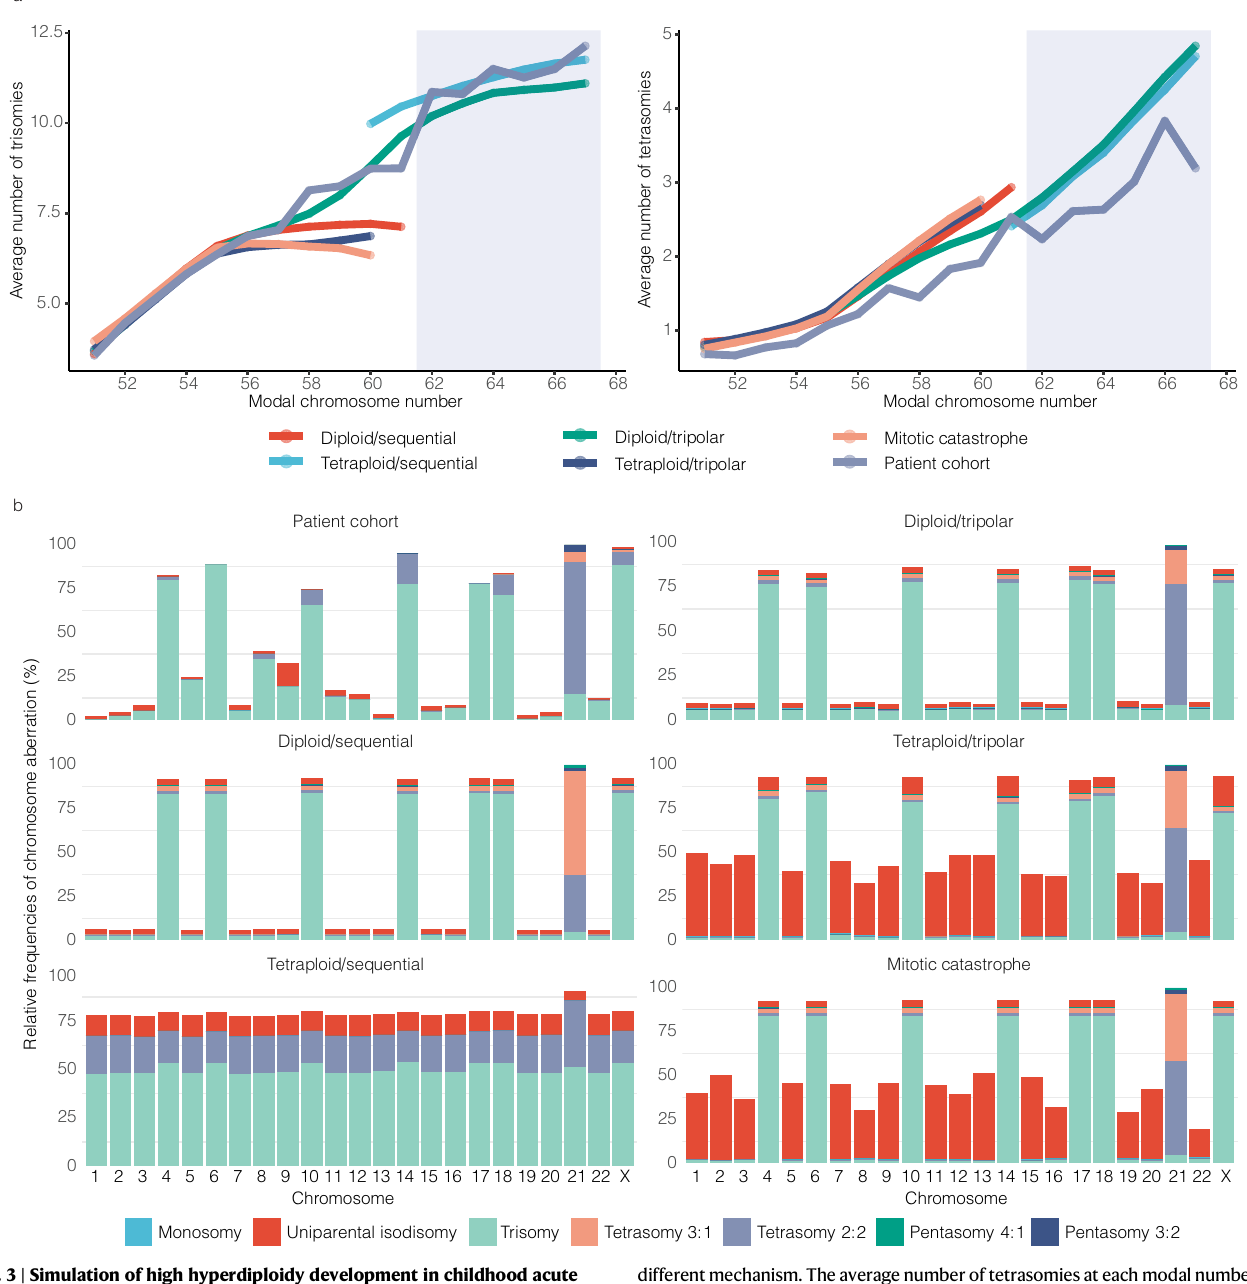
differentmechanism.Theaveragenumberoftetrasomiesateachmodalnumberin the patient cohort is based on fewer chromosomes (since tetrasomies are less common than trisomies) and follows most closely the diploid/tripolar and the tetraploid/sequential models for MCN 51 – 61 and MCN 62 – 27, respectively. b Pattern of chromosomal copy number changes and uniparental isodisomies resulting from the simulations according to each model and in the patient cohort. Frequency of each type of aberration (as given in the legend) is seen on the Y axis andeachchromosome(exceptY)ontheXaxis.Whereasthetetraploid/sequential, tetraploid/tripolar, and mitotic catastrophe model all result in chromosomal pat- terns verydifferent from the one seen inthe patient cohort, the diploid/sequential model, diploid/tripolar model, and patient cohort display relatively similar pat- terns. However, based on the high frequency of 3:1 tetrasomies in the diploid/ sequential model itcould be excluded, leaving the chromosomal pattern resulting from the diploid/tripolar model most similar to the one seen in the primary cases. Source data are provided as a Source Data fi